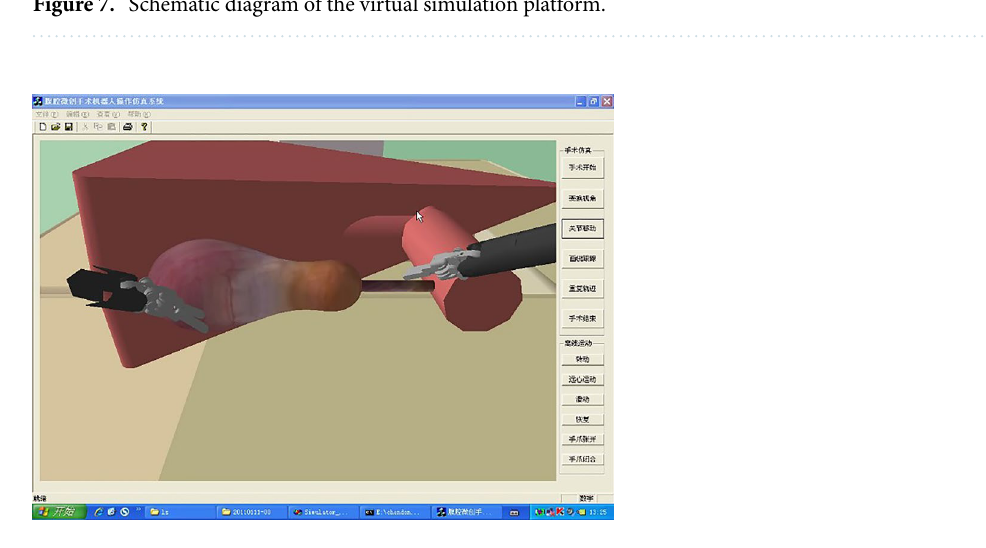
Figure 8. Simple graphic simulation